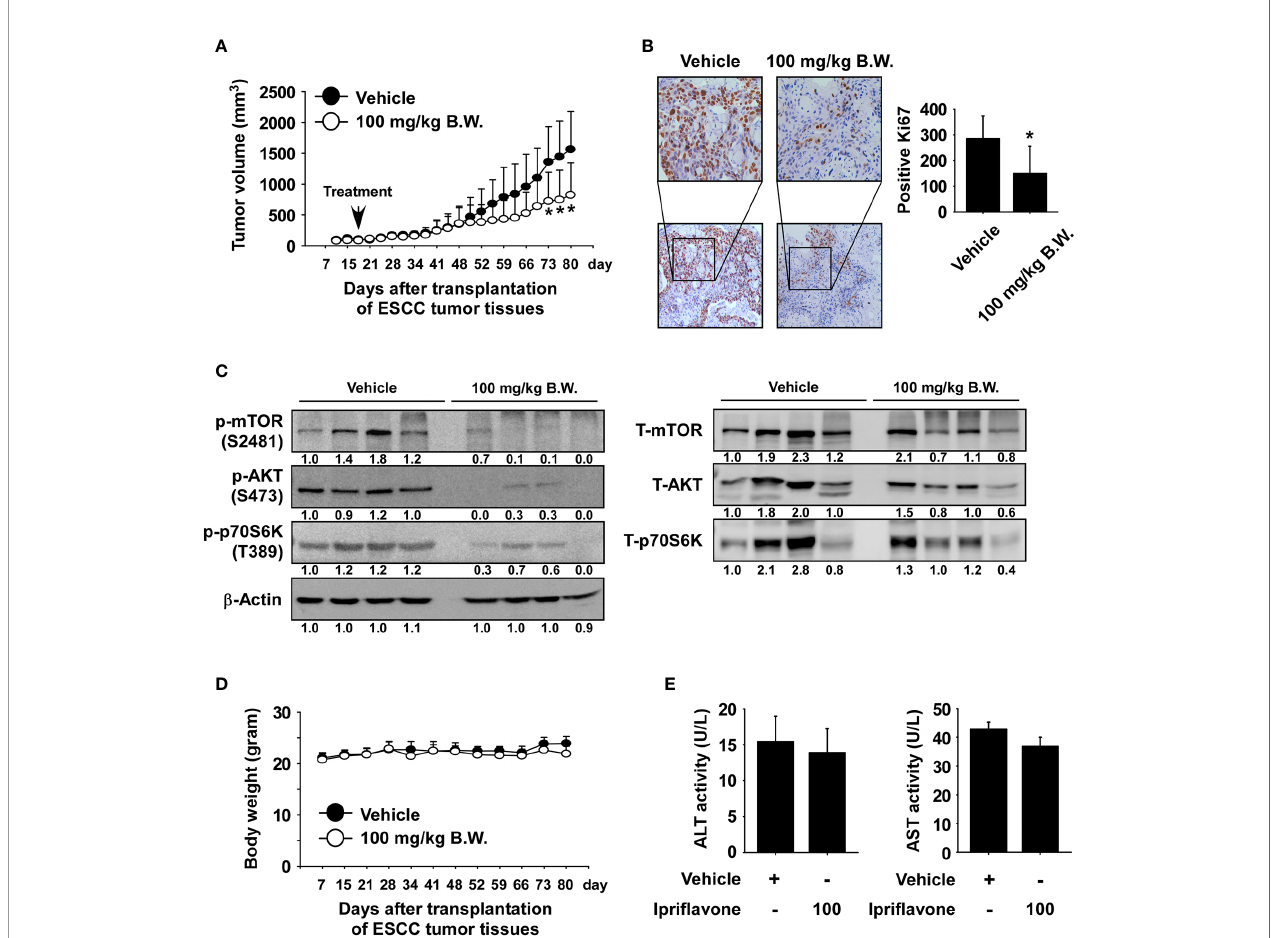
FIGURE 6 | Ipri fl avone inhibits ESCC patient ‐ derived tumor growth in vivo . Mice were divided into two groups for assessing the effect of Ipri fl avone on ESCC PDX tumor growth. Groups are as follows: 1) vehicle group or 2) group treated with 100 mg/kg of Ipri fl avone. Tumor-bearing mice were orally administered (by gavage) Ipri fl avone or vehicle once a day Monday through Friday for 62 days. Tumor volumes were measured on the days indicated. (A) The effect of Ipri fl avone on ESCC tumor growth. (B) Effect of Ipri fl avone on Ki ‐ 67 expression. Vehicle and Ipri fl avone groups of tumor tissues were stained with Ki ‐ 67 antibody (×40, ×100 magni fi cation, left panel ). The number of Ki ‐ 67 ‐ stained cells was counted from immunohistochemistry results (n = 6; * P < 0.05) ( right panel ). (C) Effect of Ipri fl avone on the mTOR signaling pathway. Vehicle and Ipri fl avone groups of tumor tissues were analyzed by Western blotting. (D) Effect of Ipri fl avone on mouse body weight. Body weights of mice were obtained once a week. Data are shown as means ± S.E. of values obtained from the experiments. (E) Effect of Ipri fl avone on ALT and AST activity. Before sacri fi ce mice, blood from vehicle and Ipri fl avone groups were collected and analyzed. All data are shown as means ± S.E. of values obtained from the experiment groups. The asterisk (*) indicates a signi fi cant difference between tumors from vehicle-treated group or Ipri fl avone-treated group mice as determined by t test ( p <